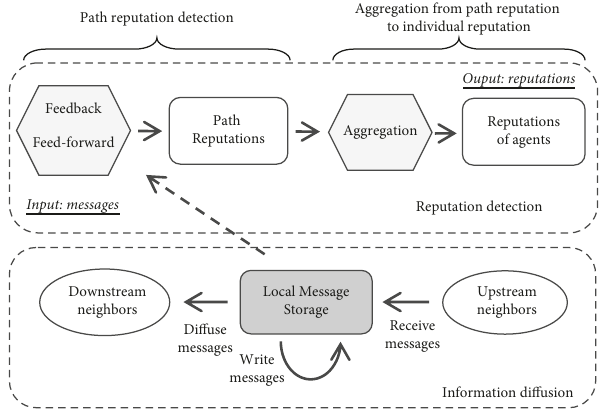
Figure 1: Reputation detection pattern “from path to